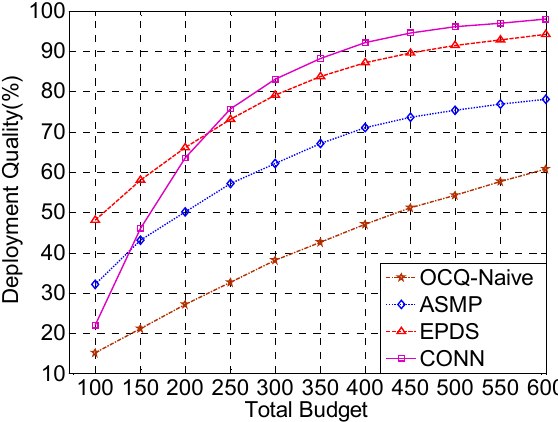
Figure 6. The CONN algorithm is compared with the ASMP, EPDS, and OCQ-Naive algorithms in terms of the deployment quality with an increasing total budget.